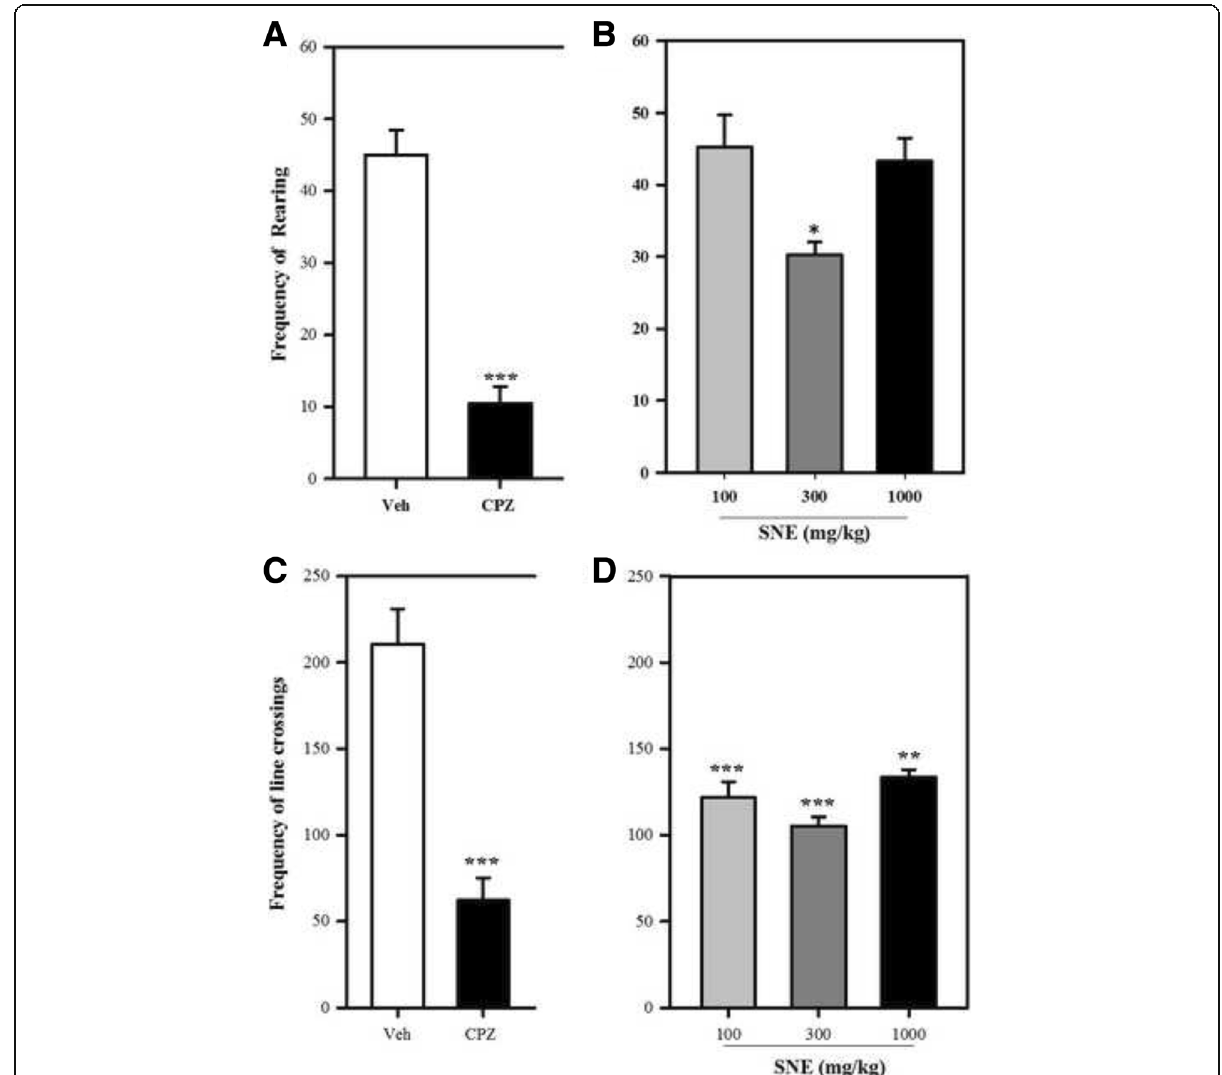
Fig. 2 Frequency of rearing ( A and B ) and line-crossings ( C and D ) of mice treated with chlorpromazine (CPZ; 1 mg/kg, i.p), SNE and vehicle (Veh) when observed for 5 min in an open-field paradigm. Data are mean ± SEM ( n = 5). * P ≤ 0.05, ** P ≤ 0.01, *** P ≤ 0.001 compared with vehicle group (one-way ANOVA followed by a Dunnett ’ s multiple comparison post hoc